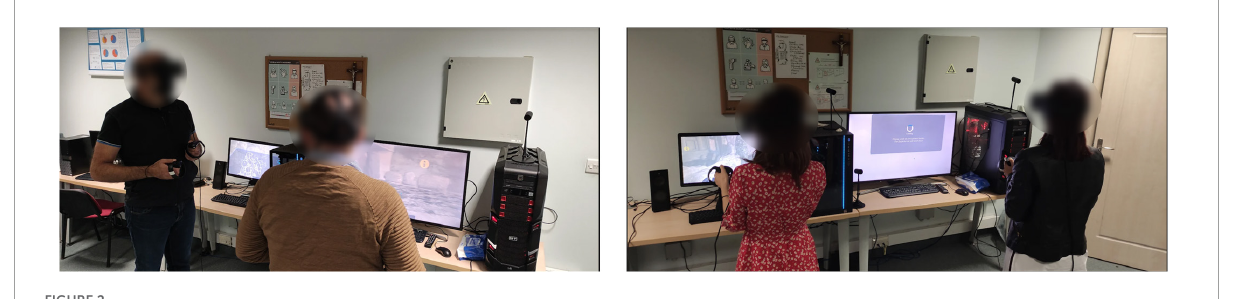
FIGURE2 Content requirement study with teachers.